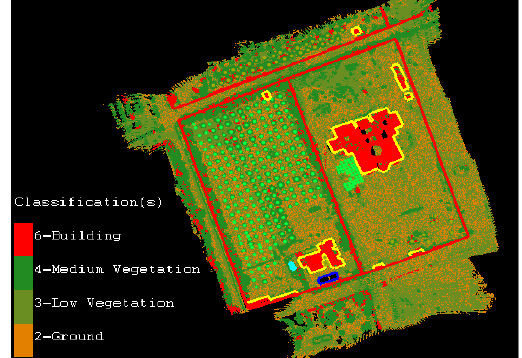
Figure 5 . The restitution superimposed on the Lidar point cloud